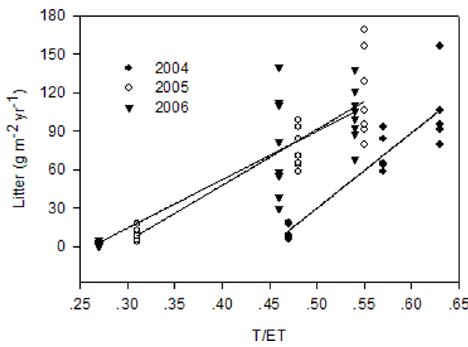
Figure 5. Relationship between litter amount and the ratio of transpiration to evapotranspiration. The regression equations for 2004: y= 2 263 + 587 x, r 2 =0.82 n=15, P , 0.001; for 2005: y= 2 126 + 435 x, r 2 =0.80, n=21, P , 0.001; for 2006: y= 2 98 + 377 x, r 2 =0.75, n=24, P ,